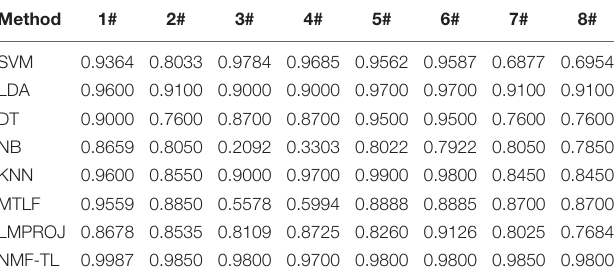
TABLE 6 | F1_score of 8 classifiers on datasets based on WPD feature extraction.